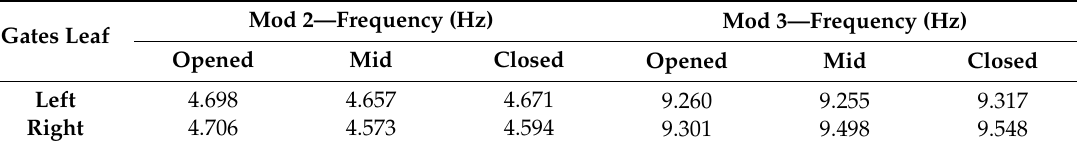
Table 1. Mean identified frequencies for each position.